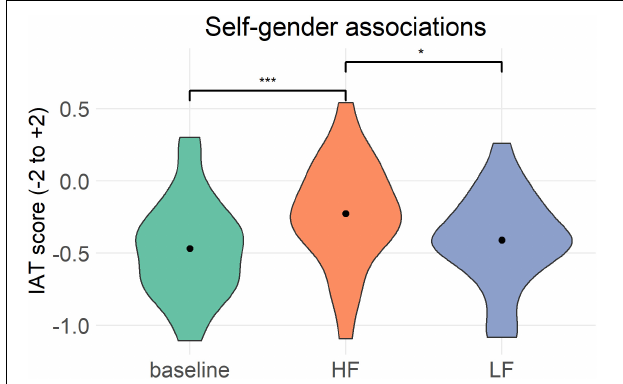
FIGURE 6 | Distribution of IAT scores (–2 to + 2) in the group of men. The black dot indicates the mean IAT score. A positive score indicates quicker association of “Self” and “Female.” A negative IAT score indicates a quicker association of “Self” and “Male.” * p ≤ 0.05, *** p ≤